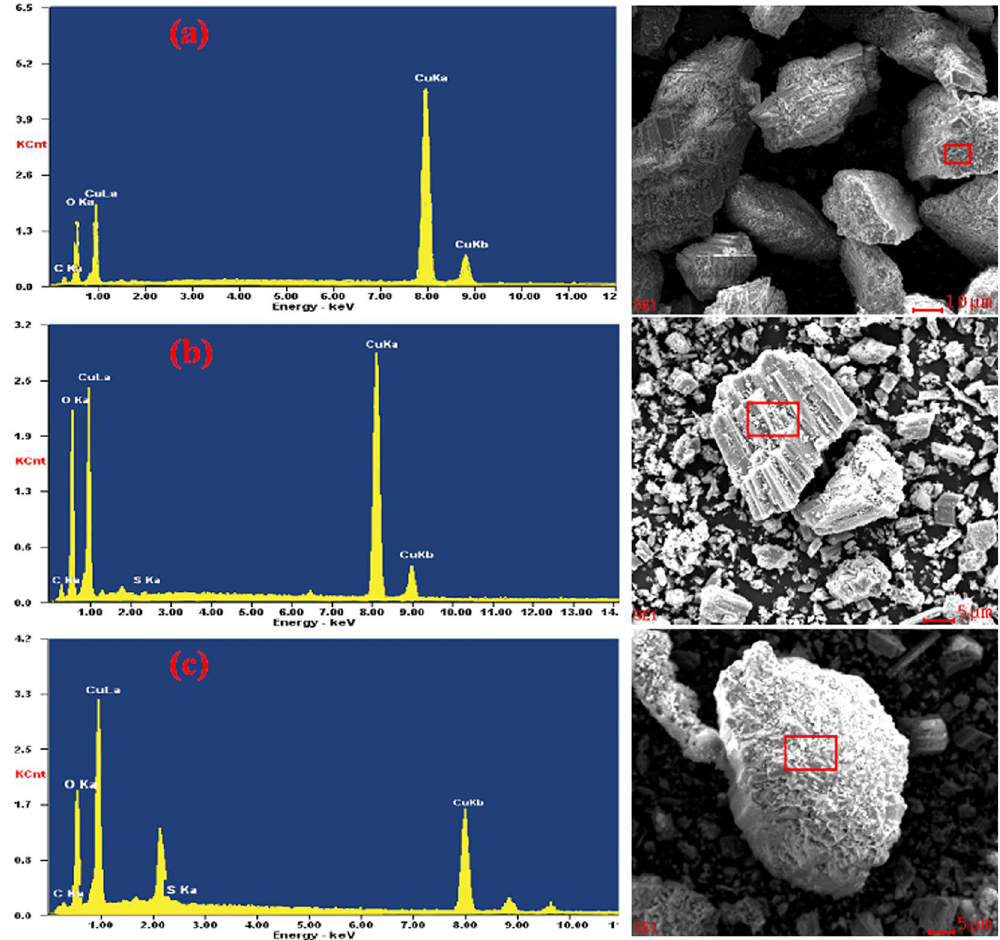
Figure 3. EDS spectra of malachite samples: ( a ) original malachite; ( b ) after sulfidation; ( c ) after enhanced